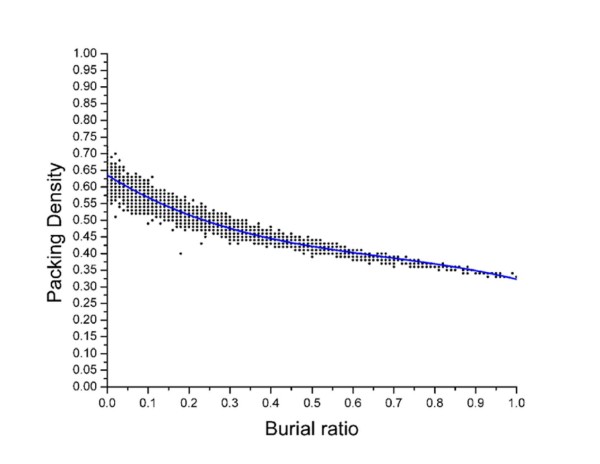
Packing density as a function of burial ratio. Packing density decays with increasing burial ratio (which is an index of the exposure to the solvent) following a cubic polynomial (plotted for tyrosine).